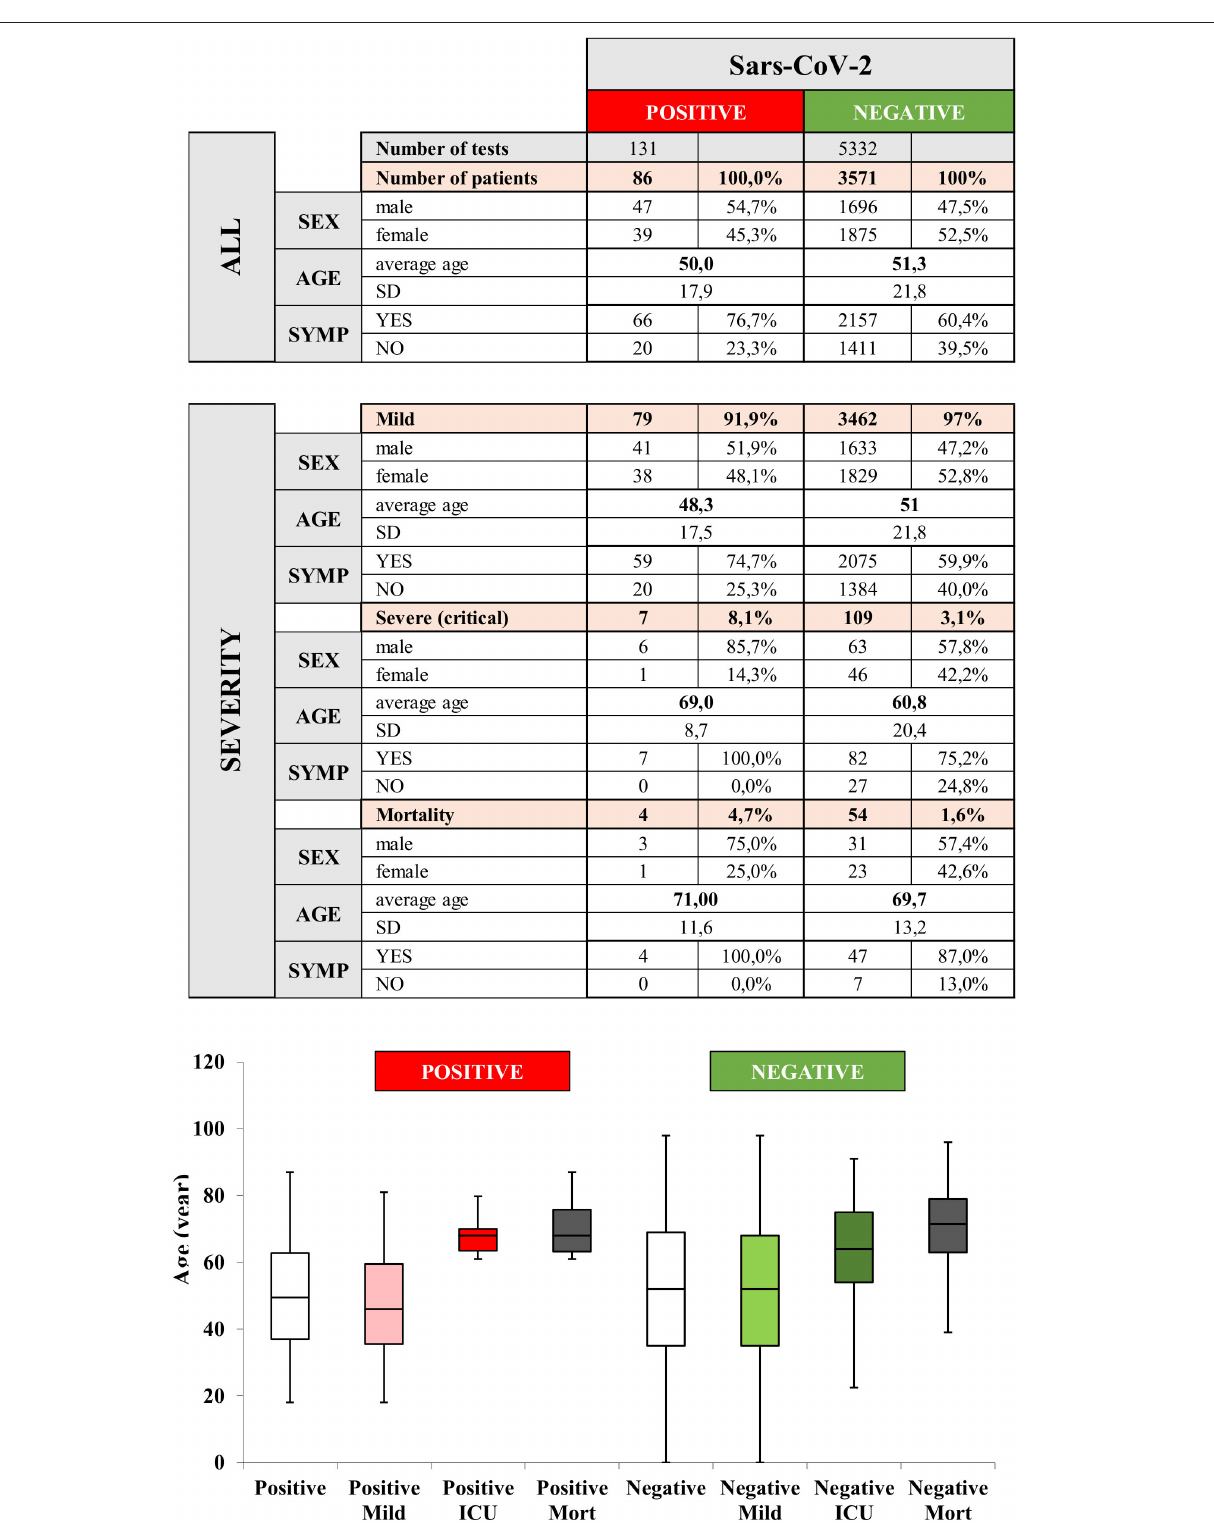
Frontiers in Medicine |